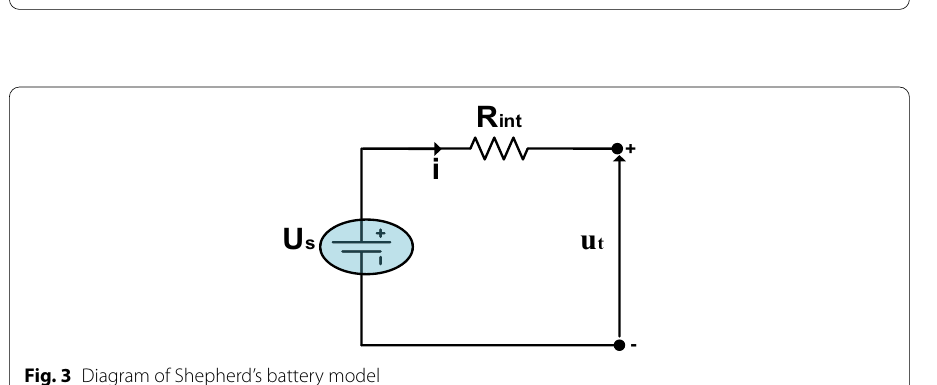
Fig. 3 Diagram of Shepherd’s battery